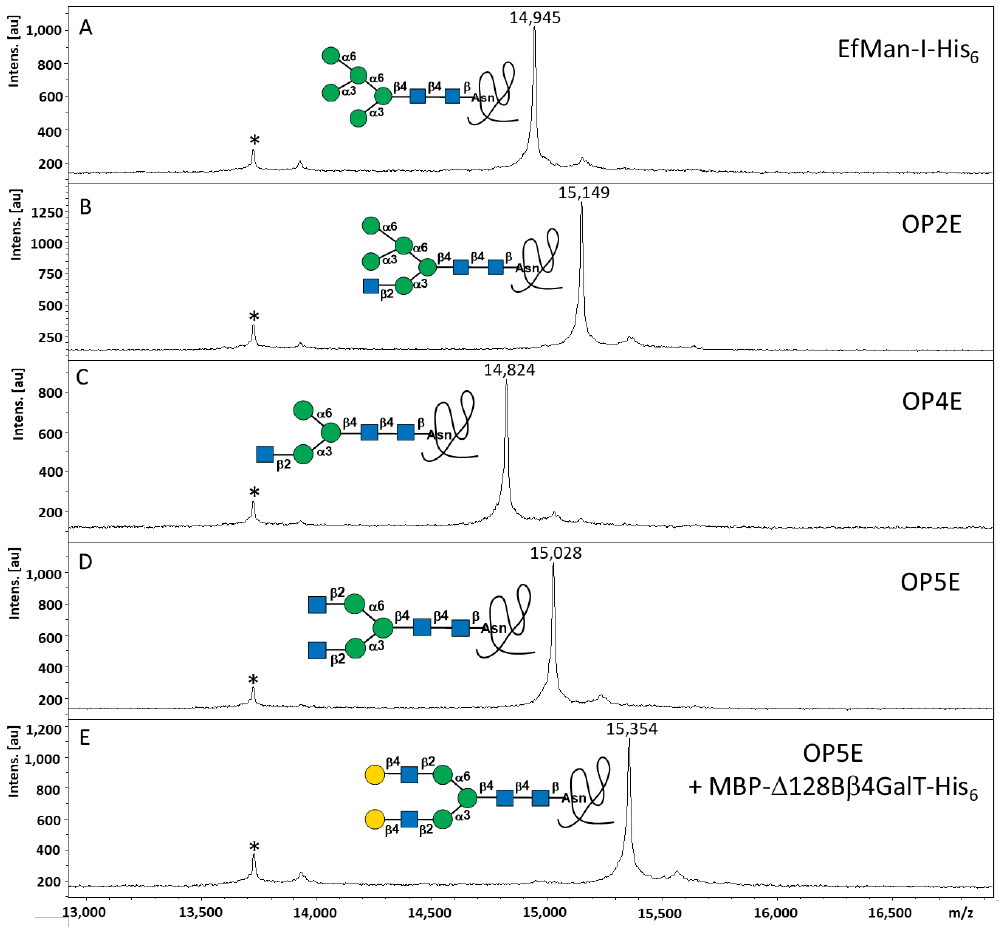
Figure 4. MALDI-TOF MS analysis results for RNase B treated with EfMan-I-His 6 for 2 h ( A ), OP2E containing EfMan-I-His 6 , MBP- ∆ 28hGnT-I-His 6 for 2 h ( B ), OP4E containing EfMan-I-His 6 , MBP-